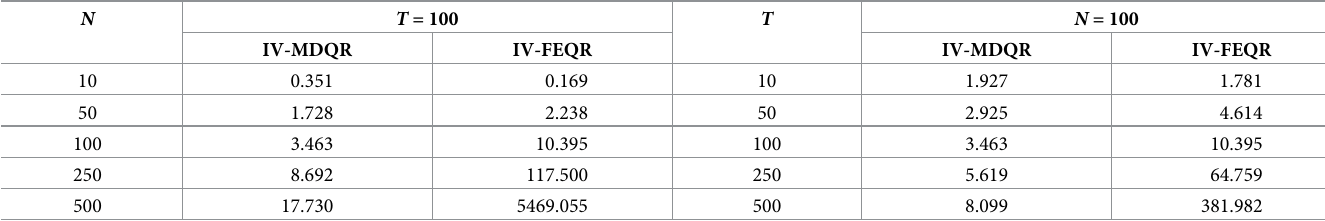
Table 4. The computing time (in seconds) of IV-FEQR and IV-MDQR estimators required for one replication under different sample size.